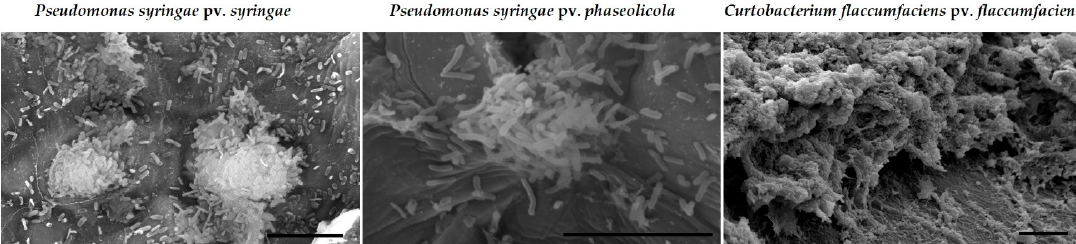
Figure 3. Scanning electron micrographs of biofilms or aggregates formed by three bacterial blight pathogens on the surfaces of dry bean tissues. The biofilms contain layers of bacterial growth and artifacts of the EPS that remains after fixation and dehydration are visible. Scale bars = 10 µm. 2.2. Fungicide and Metallic Cation Effects on Biofilms Formed by Bacterial Blight and White Mold Pathogens